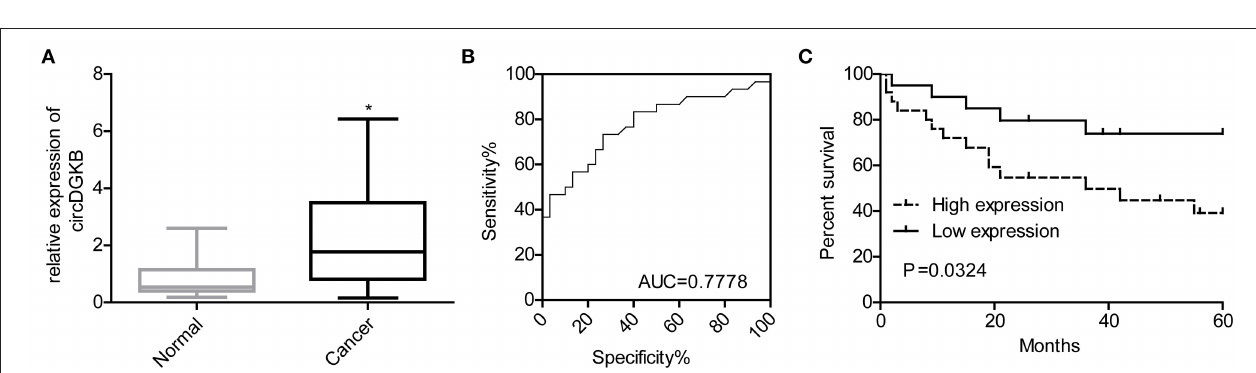
FIGURE 9 | circDGKB showed potential in the diagnosis of NB. (A) Expression level of circDGKB in blood samples of NB patients was detected by qRT-PCR, * P < 0.05. (B) ROC curve was established to evaluate the clinical value of circDGKB in the diagnosis of NB. (C) The effect of circDGKB expression level in predicting the overall survival rates of NB patients was assessed by using Kaplan-Meier analysis with log rank test ( n = 45, P =